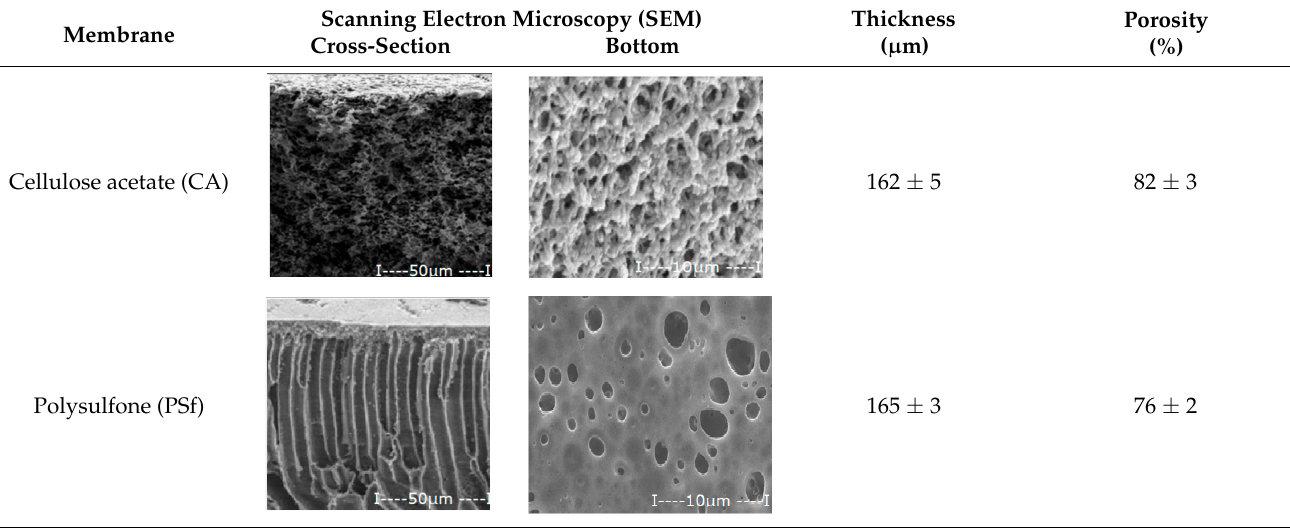
Table 3. The characteristics of the membrane support.